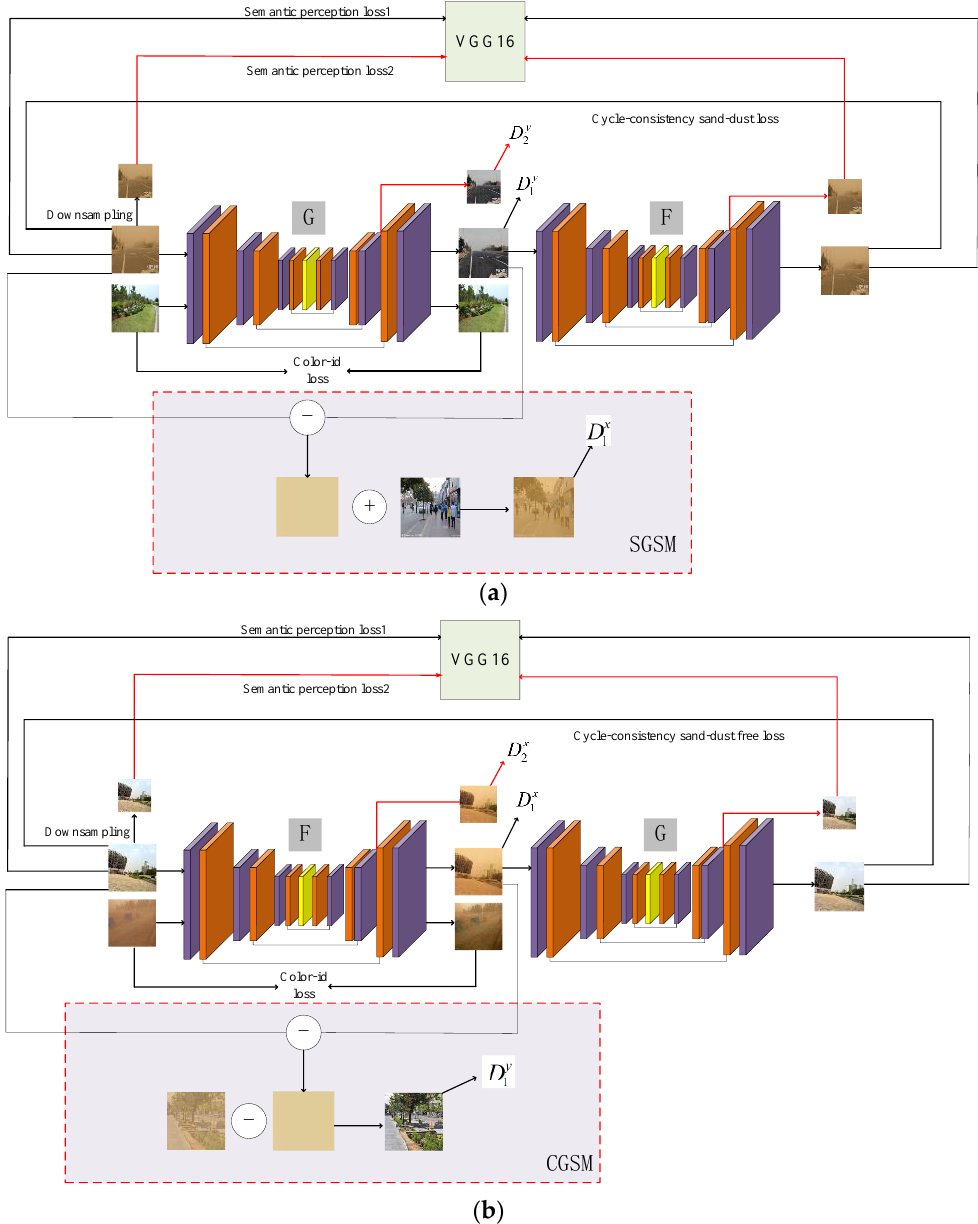
Figure 2. The overall framework of D-CycleGAN; ( a ) The cycle of sand image – clean image – sand image; ( b ) The cycle of clean image – sand image – clean image.